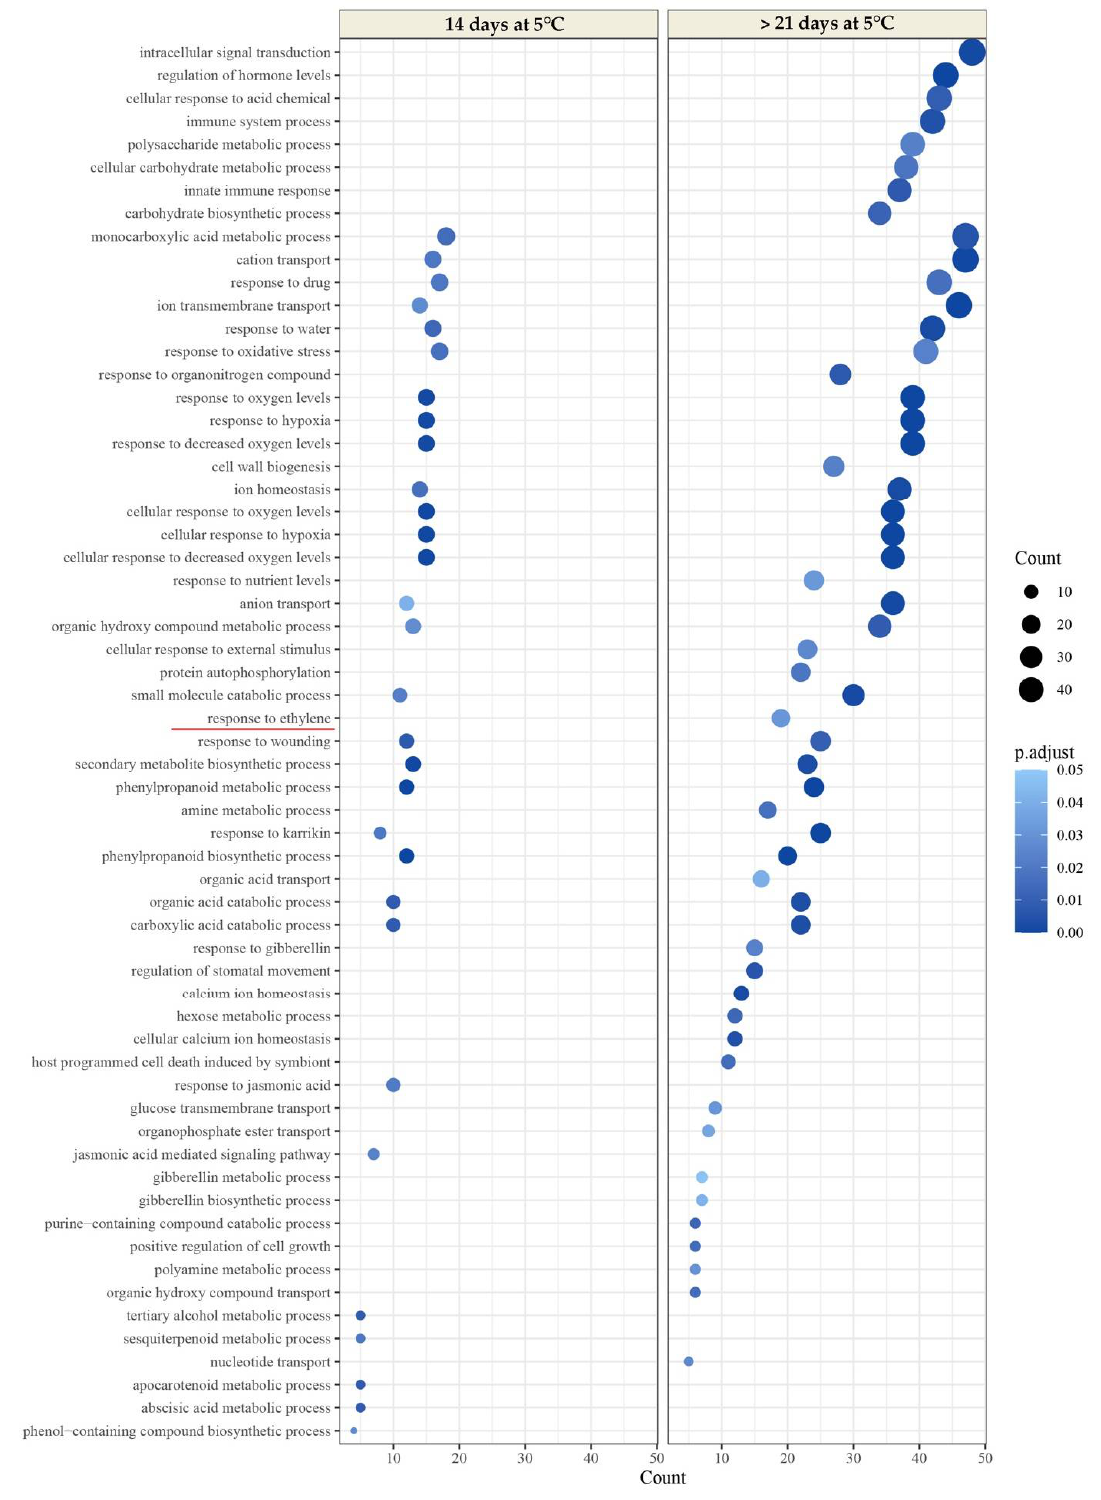
Figure 5. Dot plot of enriched Gene Ontology (GO) terms for the upregulated genes by cold storage compared with fruit at harvest of HDM. The Y -axis indicates the GO term, and the X -axis shows the count of genes per GO term. The input upregulated genes were 356 and 1428 for 14 d at 5 ◦ C and >21 d at 5 ◦ C, respectively. The color gradient indicates the adjusted p -value (0.05) using the Benjamin-Hochberg method. The GO term ‘response to ethylene’ (GO: 0009723) is marked in a red line